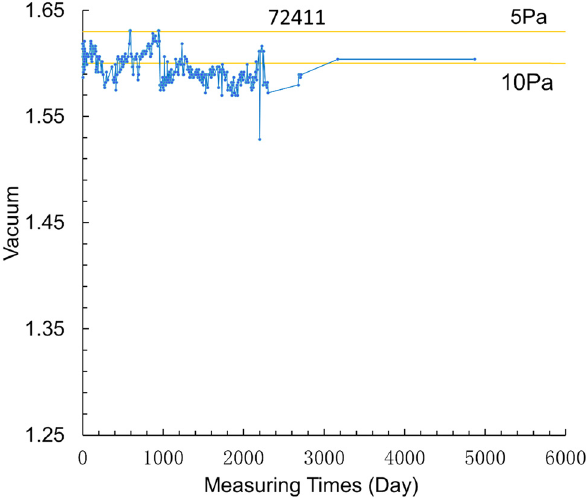
Figure A4: Relationship between vacuum holding voltage and time in No. 72419 vacuum packaging